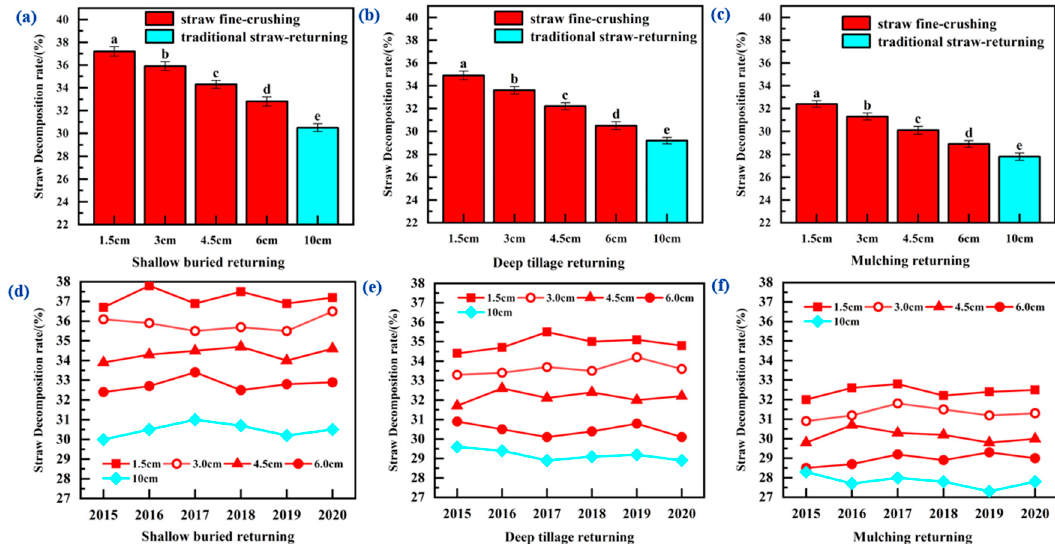
Figure 3. Six-year average of SDR shown in ( a – c ) and SDR values for each year shown in ( d – f ). Averages followed by different lowercase letters are significantly different according to LSD’s multiple range experiment at the significance level of 0.05. Error bars are standard deviation.